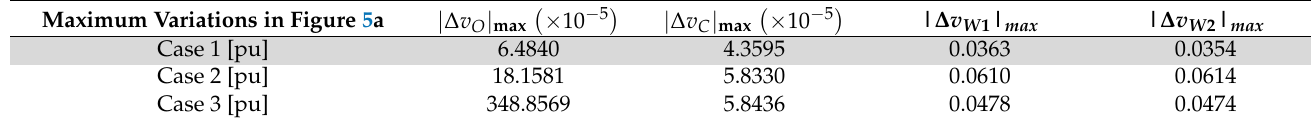
Table 6. Comparison of continuous response test results.